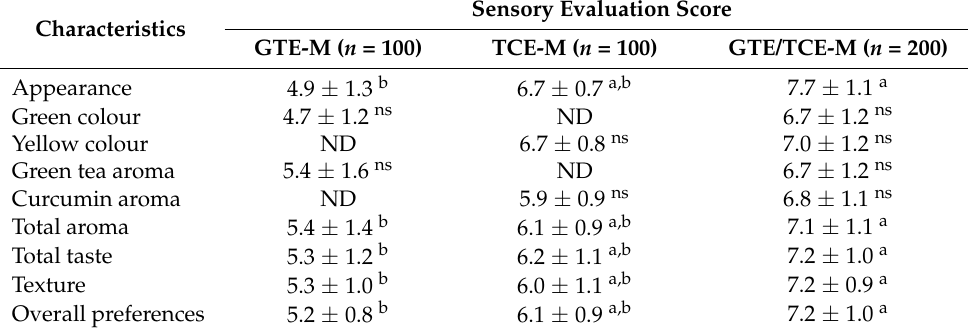
Table 4. Sensory test with respect to GTE-M, TCE-M and GTE/TCE-M products using a 9-point hedonic scale. A 9-point hedonic scale was applied as follows: 1 = dislike extremely, 2 = dislike very much, 3 = dislike moderately, 4 = dislike slightly, 5 = neither like nor dislike, 6 = like slightly, 7 = like moderately, 8 = like very much to 9 = like extremely. Data are expressed as mean ± SD values. Within the same parameters, values followed by different superscript letters ( a,b ) are indicative of significant differences ( p <